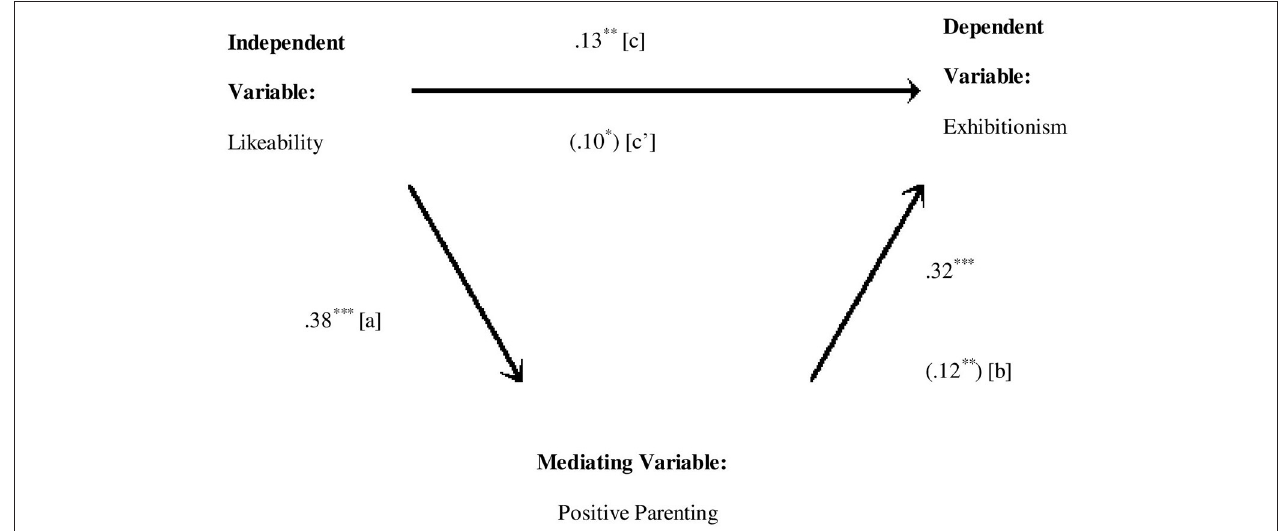
FIGURE 3 | Medgraph shows indirect effect of likeability and exhibitionism through positive parenting (perceived). The numerical values in parentheses are beta weights taken from the second regression and the other values are zero order correlations. *** p < 0.001, ** p < 0.01 and * p <